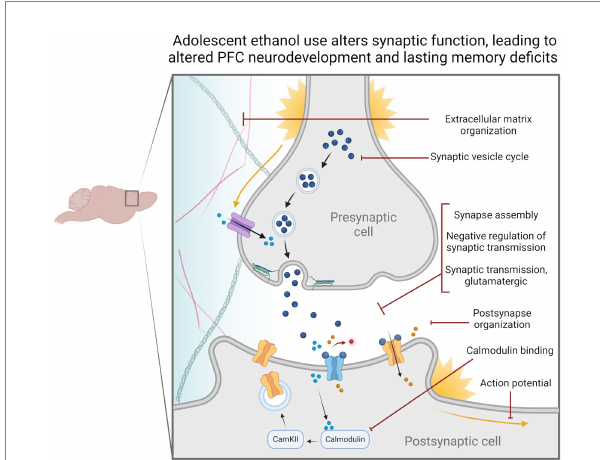
FIGURE 6 Adolescent binge ethanol alters the regulation and expression of genes relating to synaptic function. Our differential gene expression, differential exon usage, cryptic transcription and differential H3K36me3 bound loci analyses identified a number of gene ontology categories related to synaptic structure and function. These changes are likely reflected in presynaptic and postsynaptic cells as well as within the extracellular matrix and may be why persistent cognitive deficits occur after adolescent binge ethanol exposure. Categories shown were significantly over-represented in at least one analysis in both males and females, p < 0.05. Extracellular matrix organization – GO:0030198, Synaptic vesicle cycle – GO:0099504, Synapse assembly – GO:0007416, Negative regulation of synaptic transmission – GO:0050805, Synaptic transmission, glutamatergic – GO:0035249, Postsynapse organization – GO:0099173, Calmodulin binding – GO:0005516, Action potential –